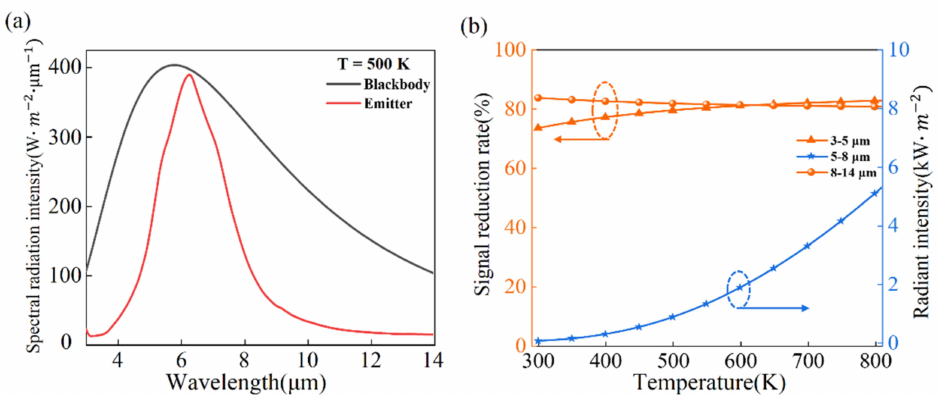
Figure 3. ( a ) The spectral radiation intensity of blackbody and emitter at 500 K, the black and red lines represent the blackbody and the cGST-Emitter, respectively; ( b ) Signal reduction rates of our designed cGST-Emitter. The carmine lines indicate the middle-IR ranges of 3–5 µ m and the longer-IR ranges 8–14 µ m, respectively. The radiant intensity of cGST thermal emitter in the wavelength range of 5 µ m–8 µ m is indicated by the blue line for various surface